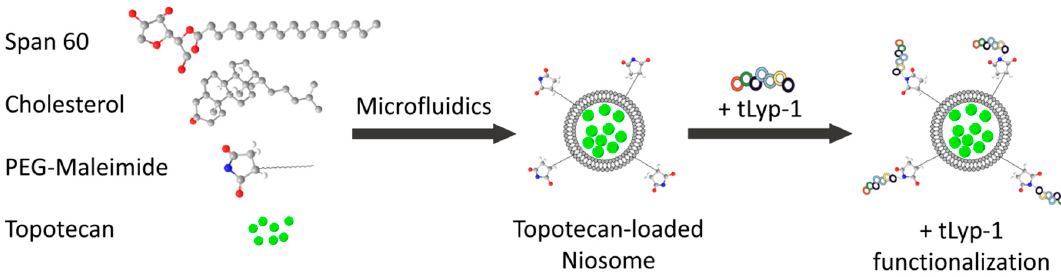
Figure 6. Schematic representation of the niosome preparation and the bioconjugation processes.